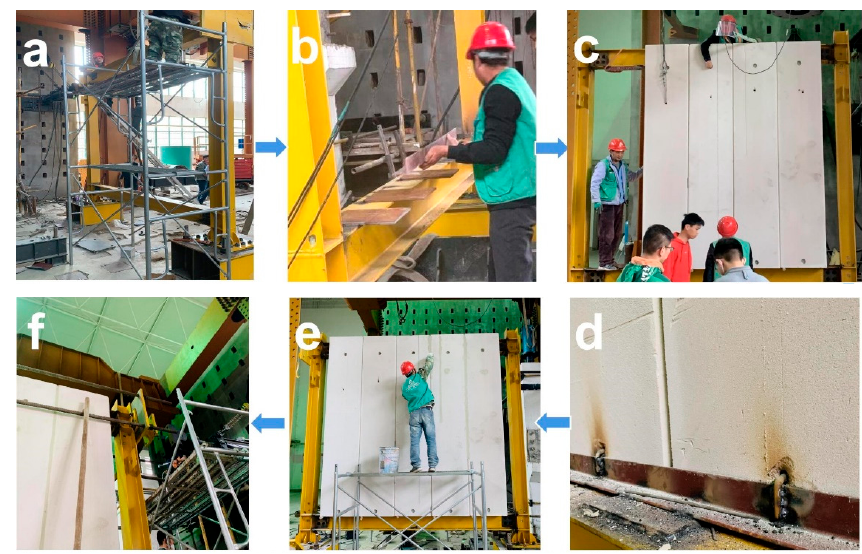
Figure 2. Assembling process: ( a ) Construction of steel frame; ( b ) Connectors are welded on beam; ( c ) ALC panels are assembled in order; ( d ) Bolts are connected to the connectors; ( e ) Special patchwork binder filled in the seam between ALC panels; ( f ) MTS device is connected to column.